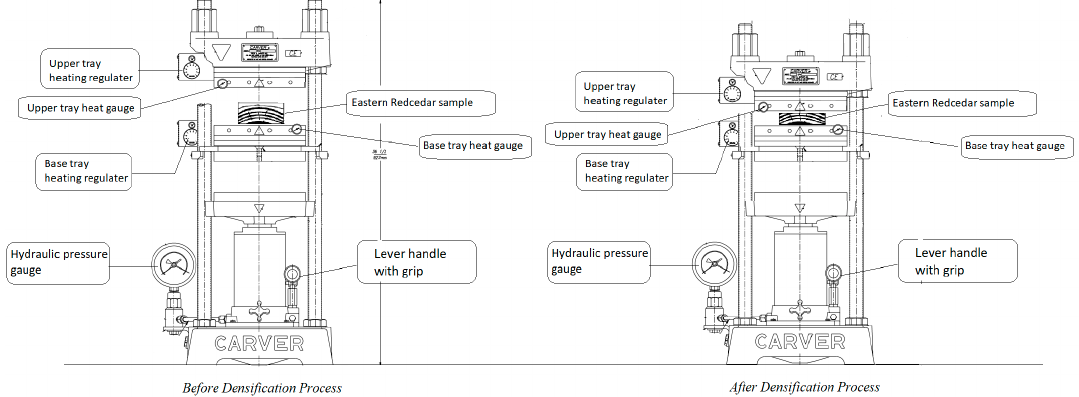
Figure 2. Densification process with Carver laboratory press and samples after densification.